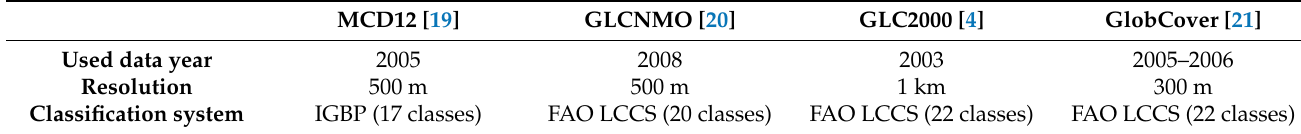
Table 4. Information of global land cover